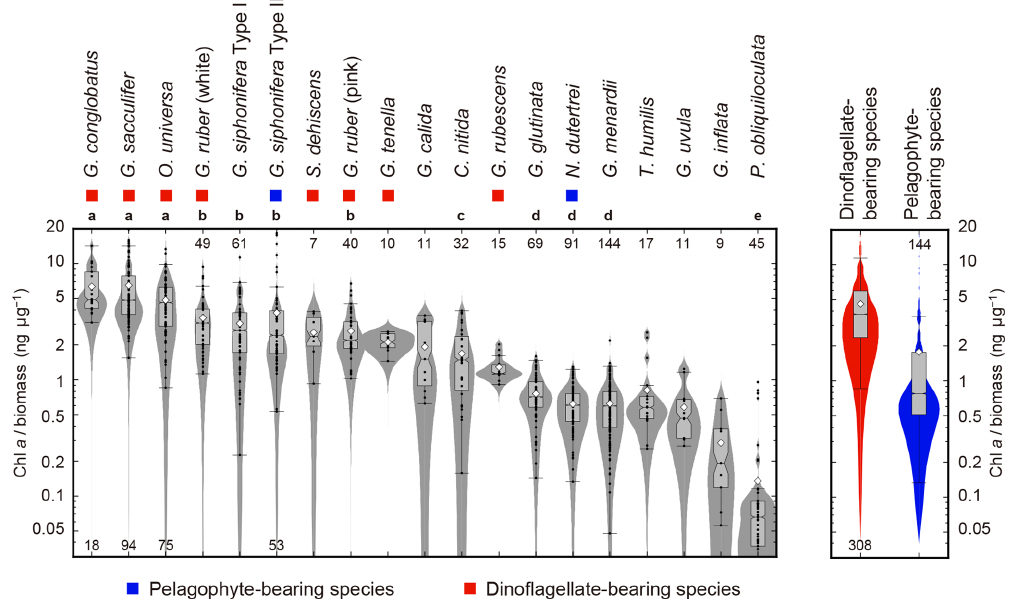
Figure 7. Ratios of Chl a content (ng foraminifer − 1 ) to protein biomass (µg foraminifer − 1 ) of 19 symbiont-bearing species. Dots represent individual data sampled from the upper 100m water depth. Box plots represent first and third quartiles as hinges, and the midlines represent medians with notches representing the 95% confidence intervals of the medians. Means are also represented with open diamonds. Values which lie more than 1.5 times the length of the box from either end of the box are considered as outliers. Violin plots show the distributions as kernel density estimations. Numbers at either end of the panel are the sample size for each species. Species with more than 20 specimens were used for statistical testing (Kruskal–Wallis test for comparison of differences in medians, and post hoc Steel–Dwass test for multiple comparison, p< 0 . 05). Species with the same letter were not significantly different. Color symbols represent the difference of symbiotic algae (see Table 1). Note that the data are represented on a logarithmic